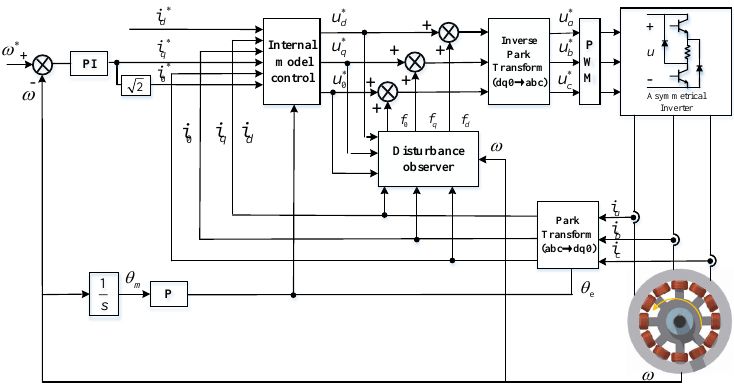
Figure 4. The structure diagram of the 2DOF IMC ADO